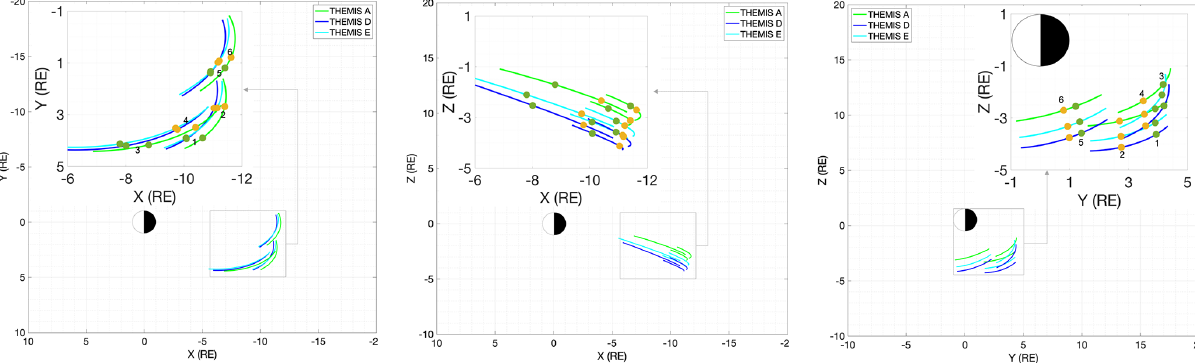
Figure 4. The location of the three THEMIS satellites (THEMIS A, D and E) in the GSM coordinate system for the selected fast flow burst Cases 1–6. The green and yellow dots indicate the exact location where each fast flow burst was observed along the spacecraft